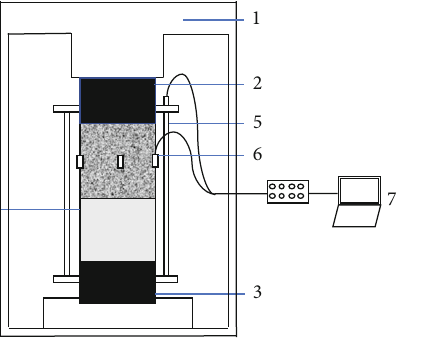
Figure 7: The test equipment. 1 the TAW-2000 testing machine, 2 upper indenter, 3 lower indenter, 4 coal-rock combination sample, 5 extensometer, 6 strain gauges, and 7 the DH3818Y static strain tester.